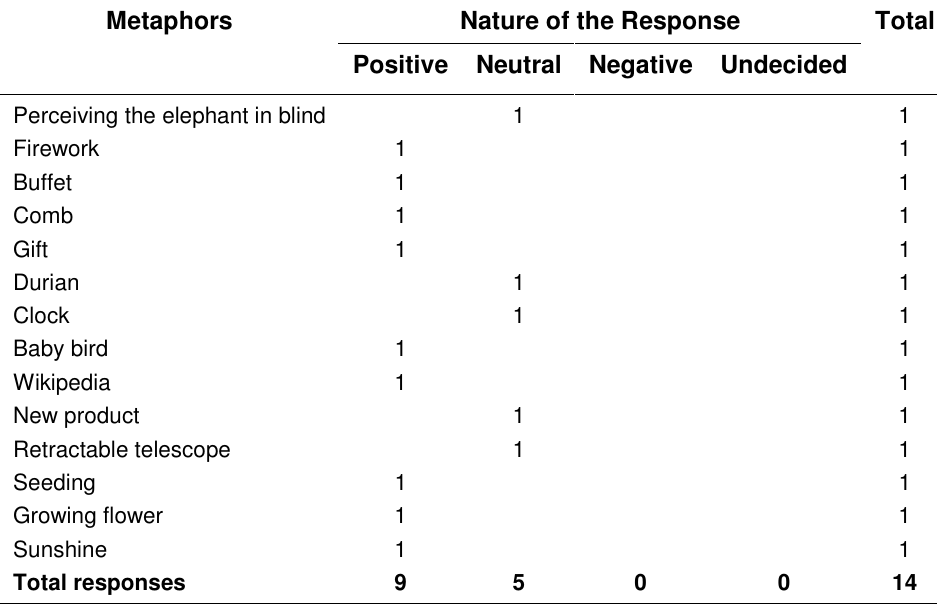
Metaphors Used by the Implementers to Represent the Program Nature of the Response Metaphors Positive Neutral Negative Undecided